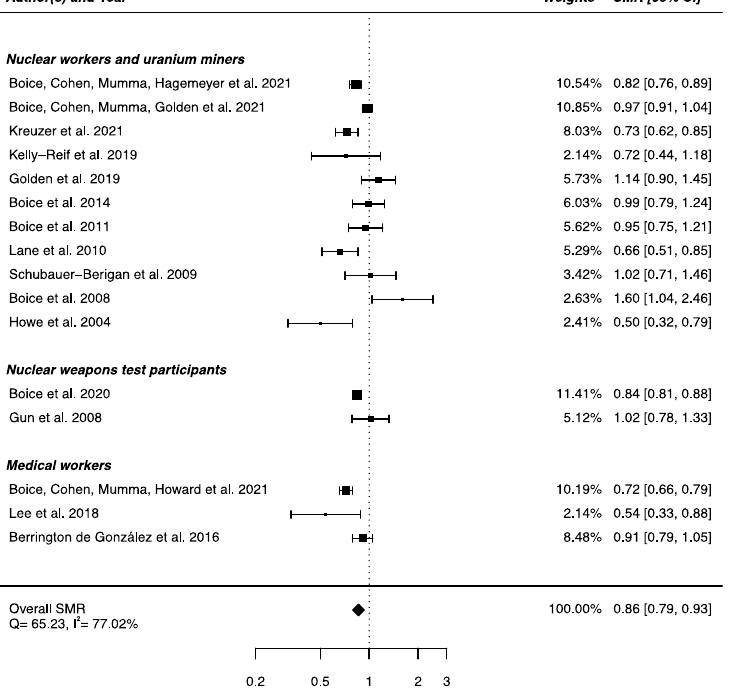
Figure 2. Standardized mortality ratio (SMR) and 95% confidence interval (CI) for mortality from diseases of the nervous system in IR-exposed populations compared with general populations as reference.